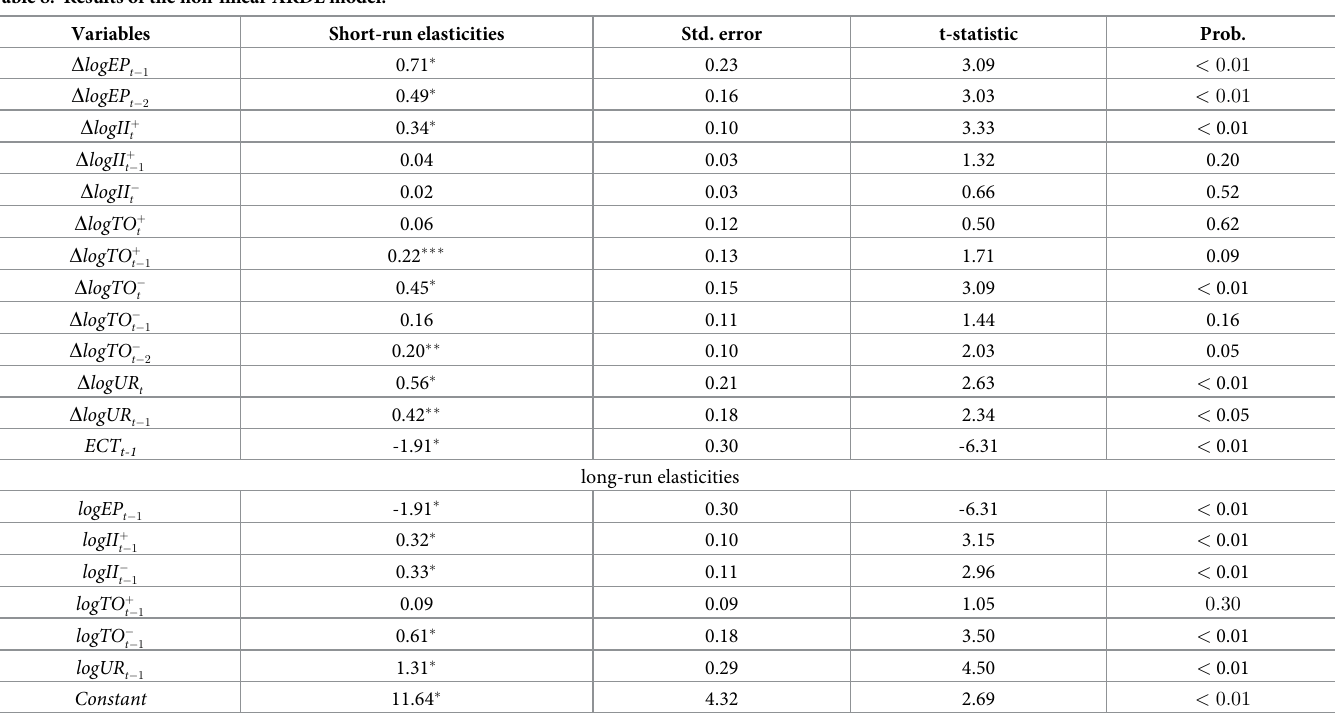
Table 8. Results of the non-linear ARDL